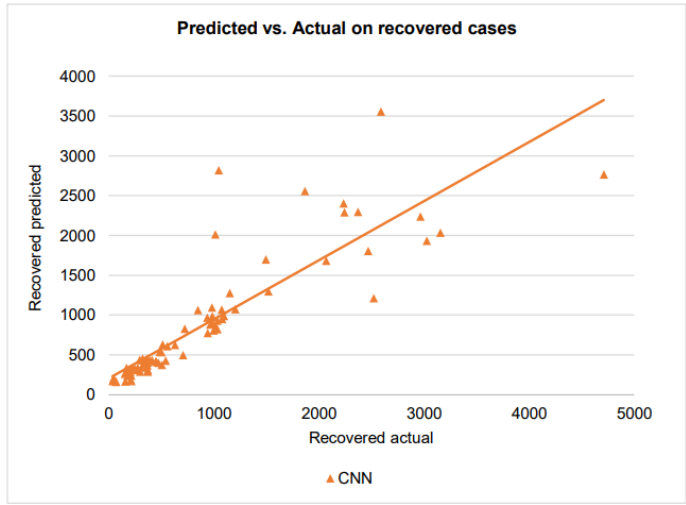
Figure 15. A scatter plot of the recovered cases by CNN on the testing dataset.